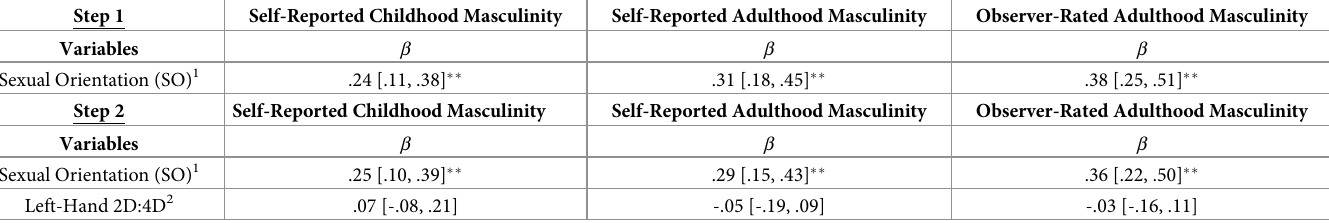
Table 2. Multiple regression analyses for sexual orientation and left-hand 2D:4D predicting self-reported childhood and adulthood masculinity (Step 1 N = 196, Step 2 N = 181) and observer-rated adulthood masculinity (Step 1 N = 191, Step 2 N = 180). Step